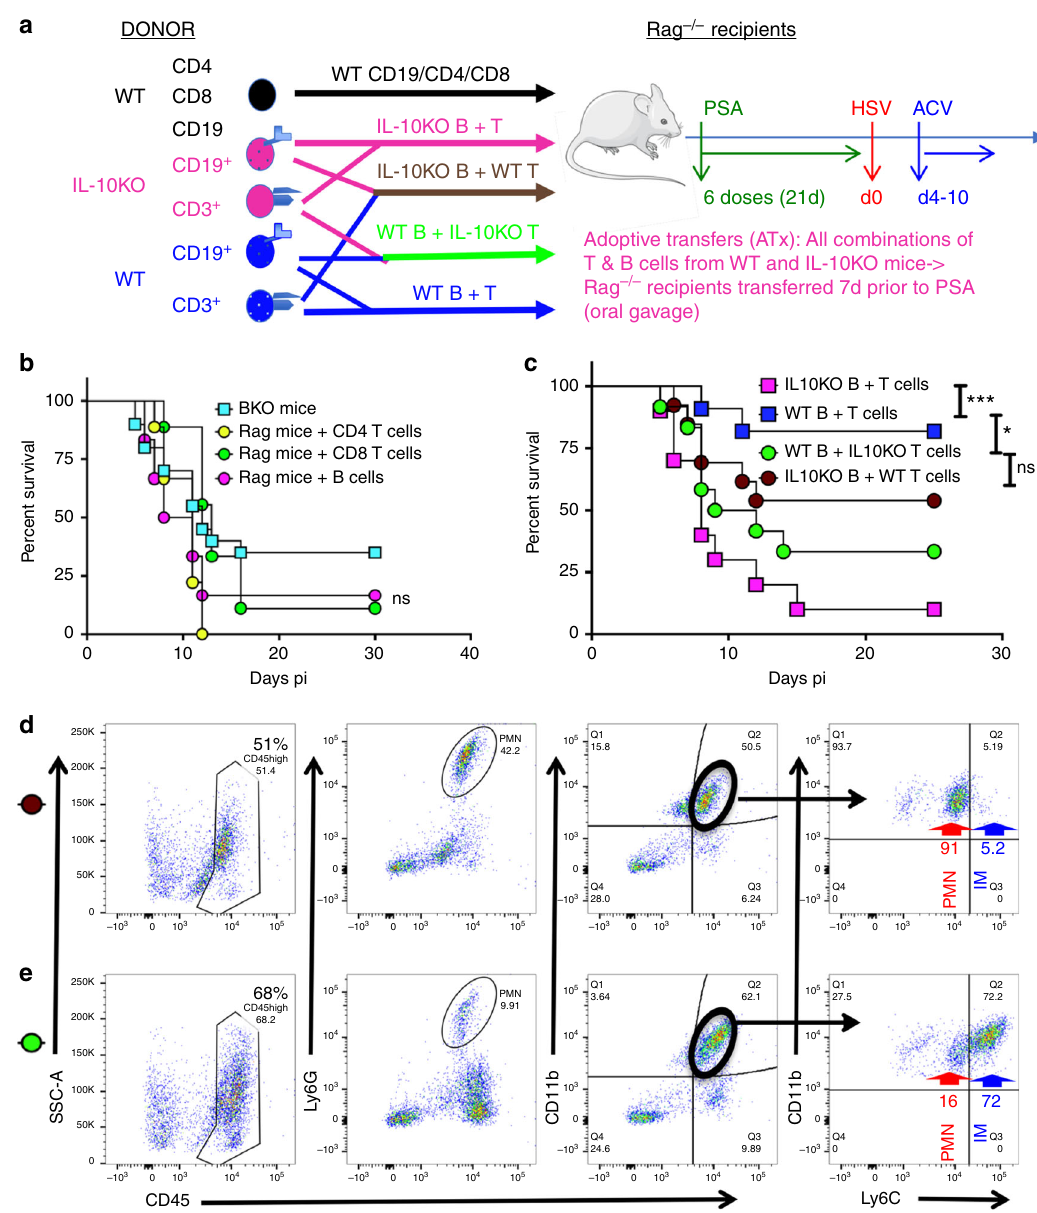
Fig. 5 PSA protection against HSE requires B and T cells secreting IL-10. a Experimental design for experiments in b and c Donor WT (In black text): Naïve Rag mice were transferred with WT CD4 + or CD8 + T cells or CD19 + B cells 7 days before PSA treatment. Donor IL-10KO (magenta text) and WT (Blue text): four groups of naïve Rag mice were transferred with combinations of donor WT B and T cells, IL-10KO B and T cells, WT B and IL-10KO T cells, IL- 10KO B and WT T cells 7-days before PSA treatment. All Rag recipients received six doses of PSA before HSV infection and ACV treatment. b Survival of B cell-depleted mice (BKO, n = 20 mice) and Rag recipients of WT single cell subsets ( n = 6 – 9 mice/group). B cell depletion in WT mice was initiated 10 days prior to PSA treatment and continued throughout infection, ns: not signi fi cant. c Survival of Rag recipients of WT and IL-10KO combination of T and B cells ( n = 10 – 13/group). *** p < 0.001, * p < 0.05, ns: not signi fi cant as determined by log rank (Mantel – Cox) test. FACS plots of BS CD45 high cells (left), Ly6G + PMN (left middle), CD11b + cells within CD45 high cells (right middle), and Ly6C high IM and Ly6C int CD11b + PMN within CD45 high CD11b + cells (right) were analyzed at day 6 pi in the BS of Rag recipients of d IL-10KO B + WT T cells (brown circle) and e WT B + IL-10KO T cells (green Rag − / − mice accounted for the divergent outcomes of HSV infection in these strains. Sections of the intestine including duodenum, ileum, and colon were isolated from WT and Rag − / − mice that had been orally gavaged with fl uorescently conjugated PSA. CD45 was used as a marker to discriminate cells of hema- topoietic origin (CD45 + ) from gut (CD45 − ) epithelial cells (Fig. 6a). CD45 − intra-epithelial cells (IEC) in both groups of mice showed binding to PSA. Although, CD45 + intra-epithelial leukocytes (IEL) in the duodenum and ileum of Rag − / − mice did